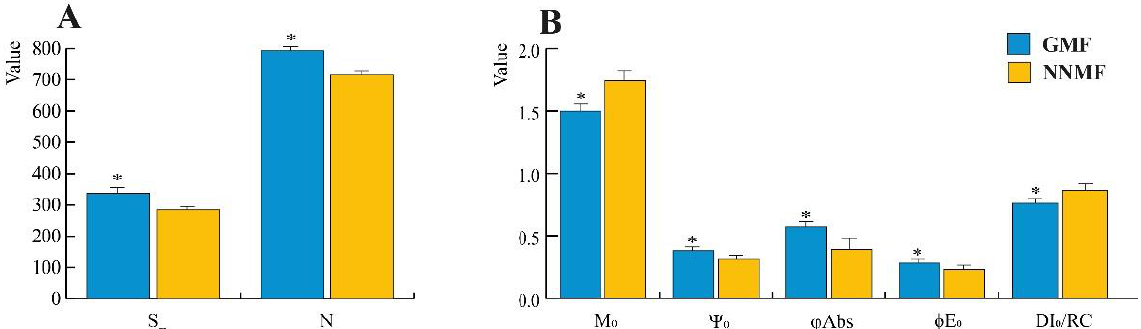
Figure 7. Reaction centers, turnover number and quantum efficiency from the OJIP fluorescence anal- ysis of Lima bean leaves exposed to either the GMF or NNMF. Asterisks indicate significant differences between the GMF and NNMF values. Metric bars indicate standard deviation. See text for symbol explanations.